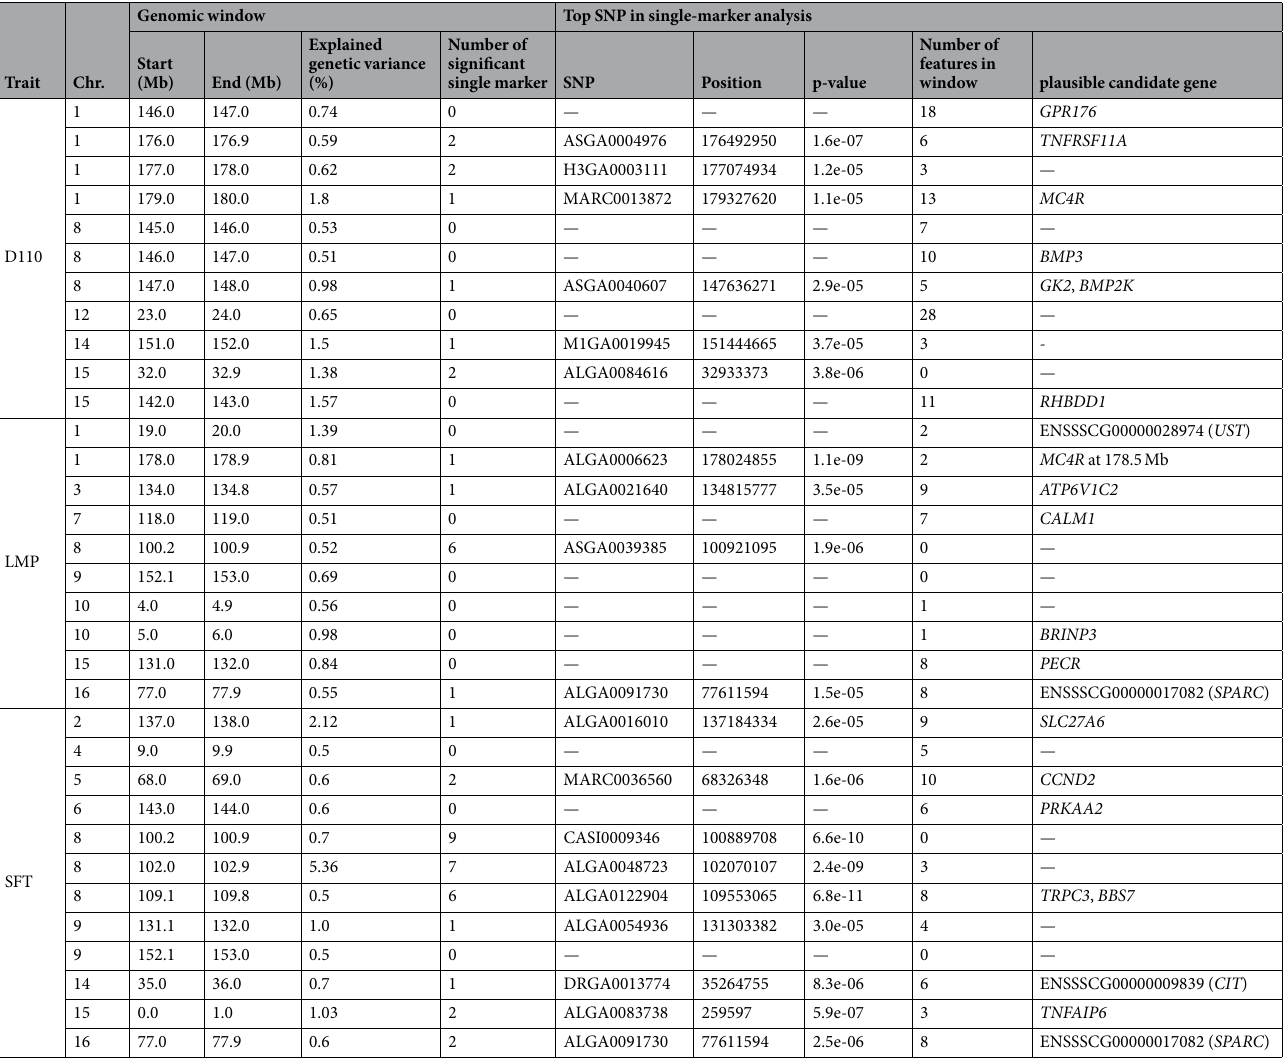
Table 1. Overview of genomic regions identified by integrating genome-wide single-marker (linear regression) and window-based (Bayes B) approaches for days to 110 kg (D110), lean mass percentage (LMP), and subcutaneous fat thickness